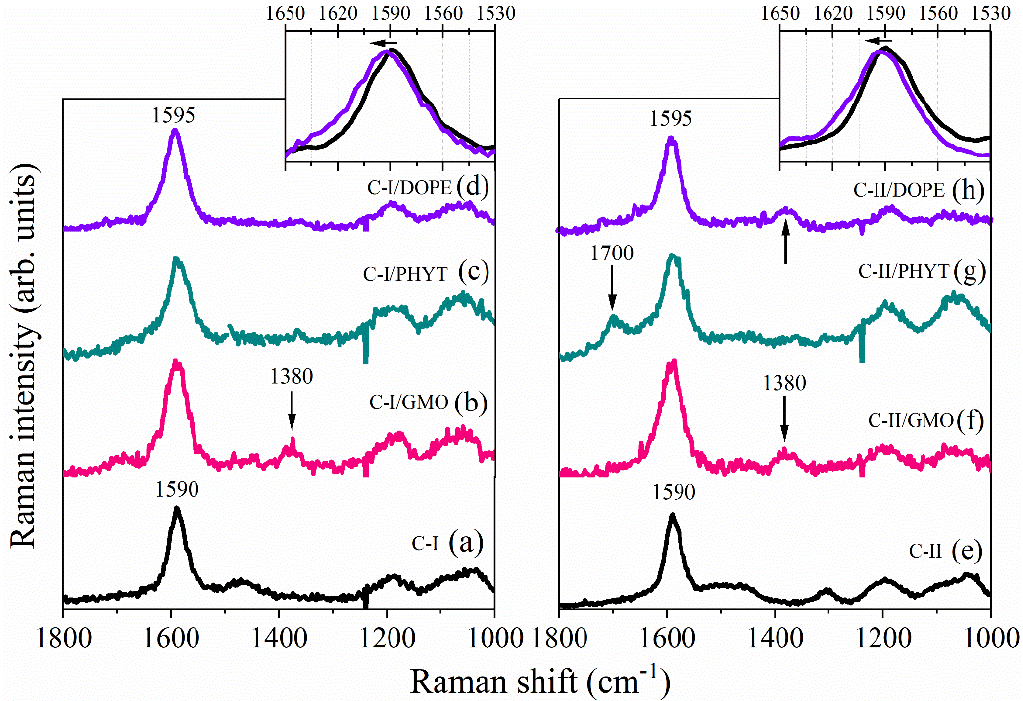
Figure 4. UVRR spectra acquired on pristine drug C-I ( a ) and on the complex formed by C-I with ( b ) GMO, ( c ) PHYT and ( d ) DOPE; on pristine drug C-II ( e ) and on the complex formed by C-II with ( f ) GMO, ( g ) PHYT and ( h ) DOPE. The spectra ( b – d , f – h ) have been subtracted from the lipid matrices signals. Insets: enlargement of the wavenumber region 1650–1530 cm − 1 for the spectra of C-I and C-I complex with DOPE (left) and spectra of C-II and C-II complex with DOPE (right).